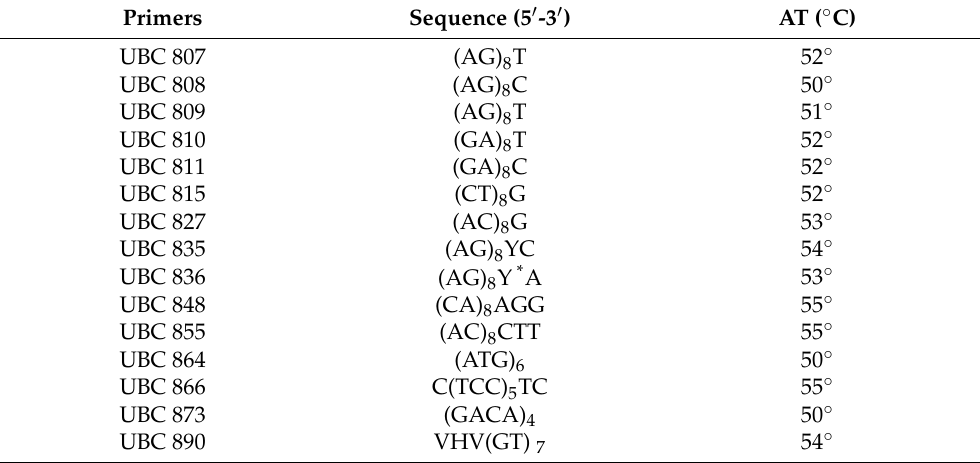
Table 2. ISSR primers used to evaluate recurrent parent genome recovery in F 2 BC 3 genotypes. AT: annealing